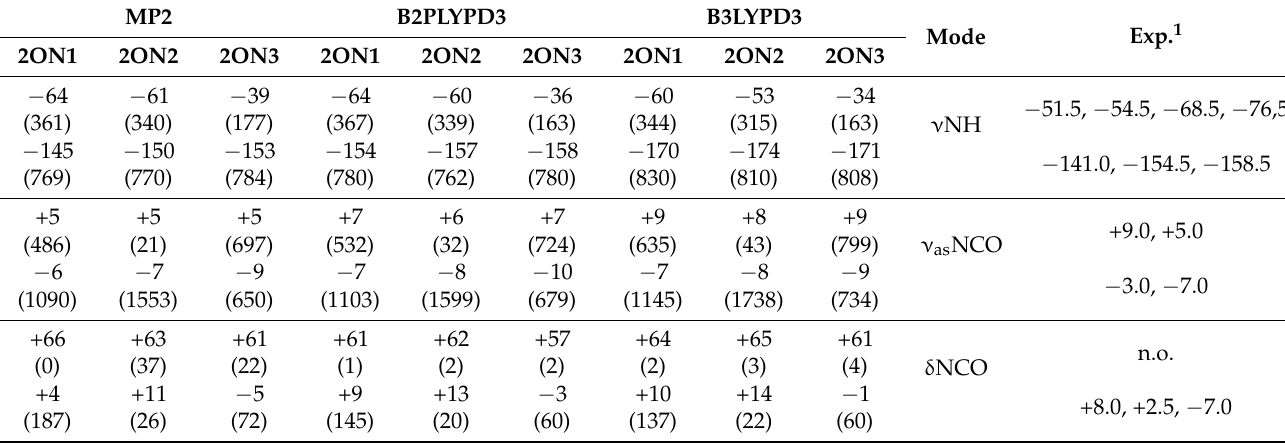
Table 7. Selected wavenumber shifts (cm − 1 ) calculated for selected 2:1 complexes using the MP2, B2PLYPD3 and B3LYPD3 methods with the 6 − 311++G(3df,3pd) basis set compared to the